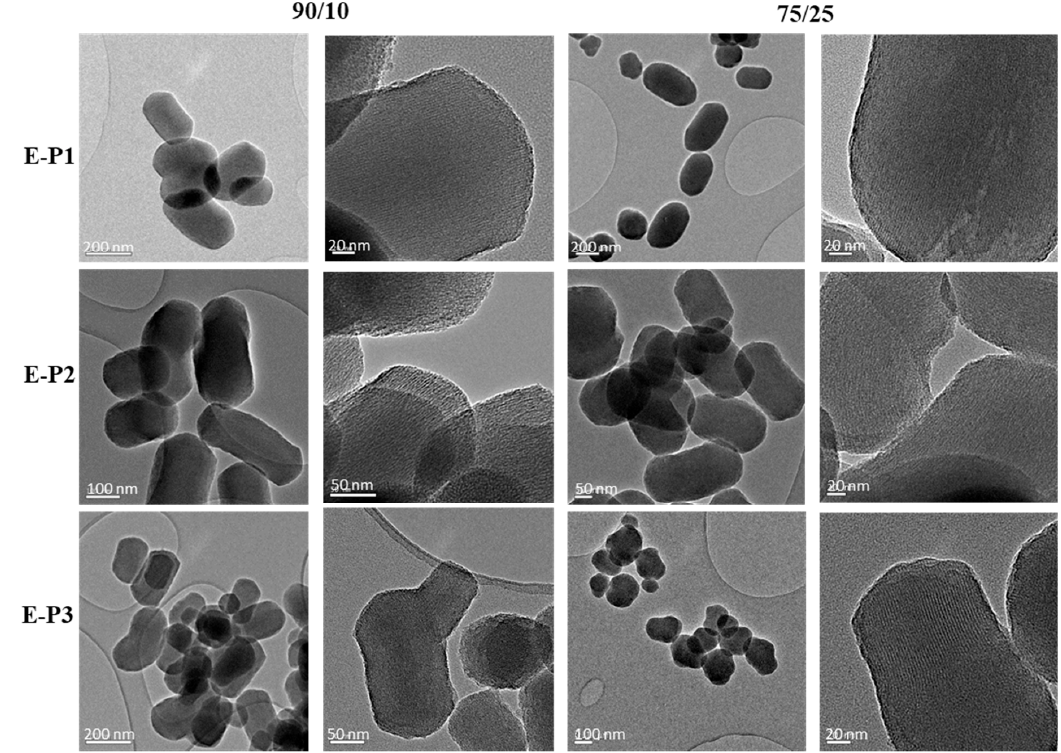
Figure 1. TEM images of PMONPs ( E ‐ P1 ; E ‐ P2 ; E ‐ P3 , proportion 90/10 and 75/25).